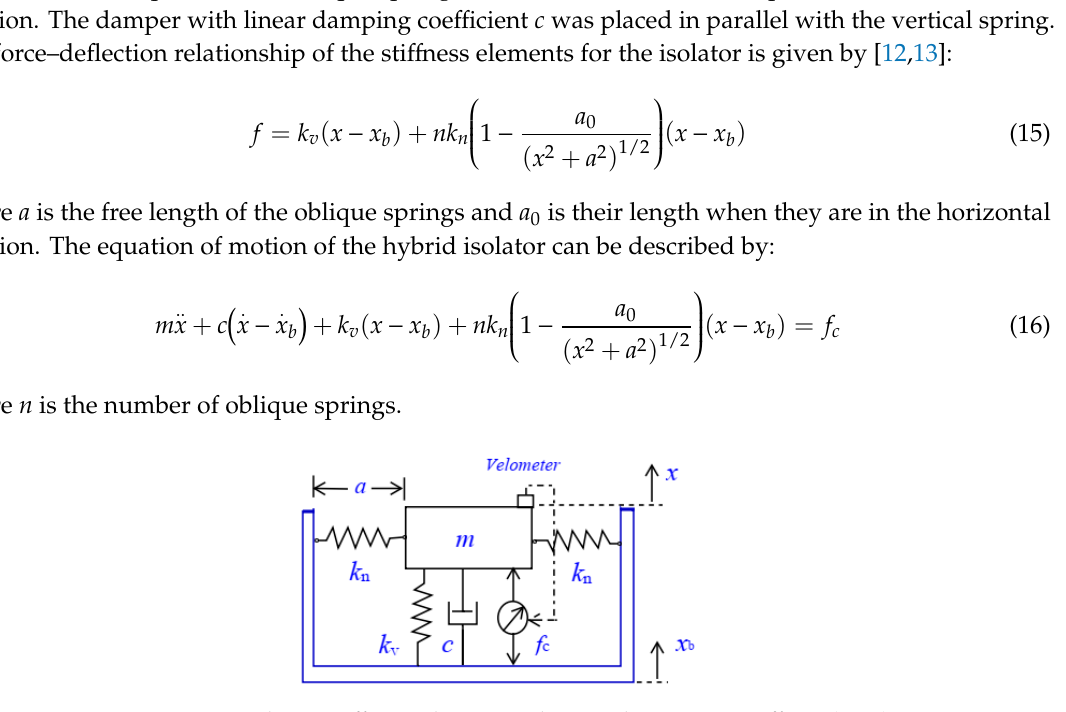
ff ness vibration isolator with quasi-zerosti ff ness Figure 2. A non-linear stiffness vibration isolator with quasi-zerostiffness (QZS). Figure 2. A non-linear sti